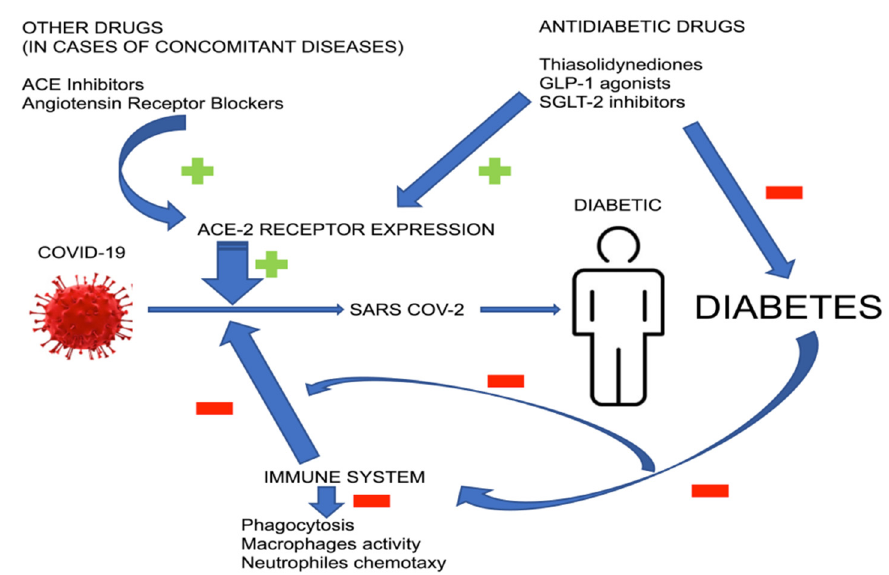
Figure 3. Patomechanisms inducing an increased possibility of COVID-19 infection in diabetic patients. Antidiabetic treatment, especially combined with other drugs, leads to overexpression of the ACE-2 receptor—a gateway for COVID-19. Deterioration of immune system function in diabetes facilitates the infection and increases its severity.